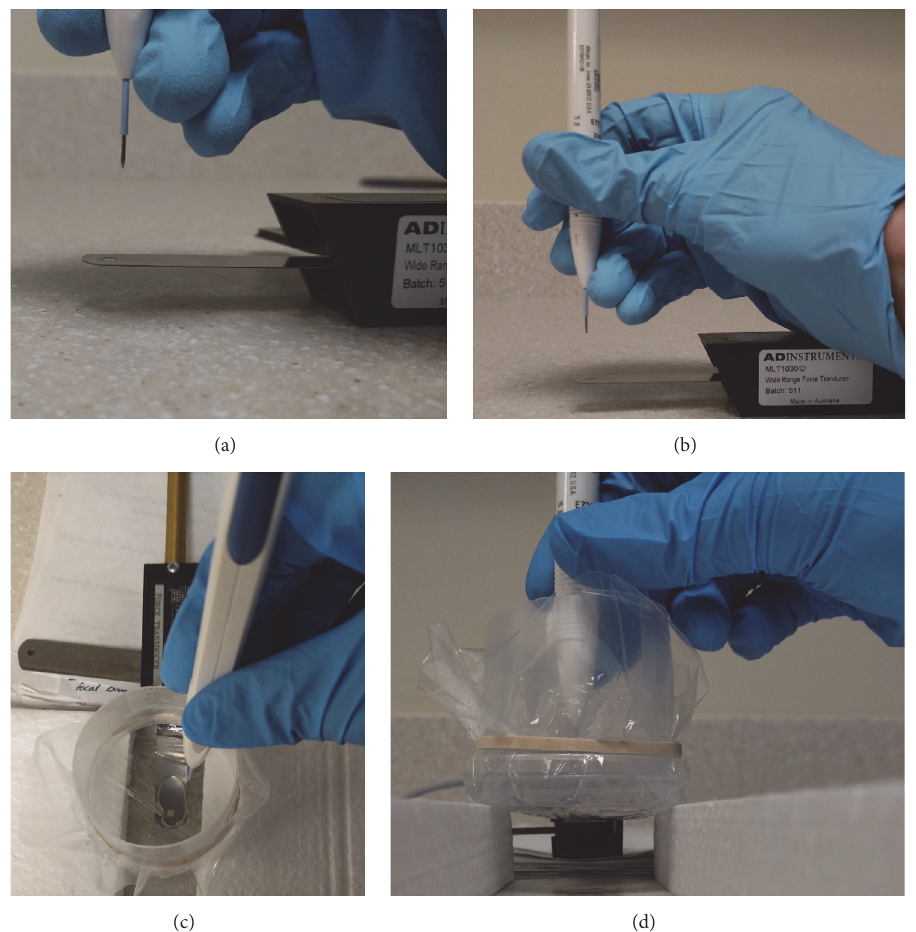
Figure 2: Experimental setup. (a) and (b) show setup for air. Ozurdex applicator held 16 mm from the force plate. Force plate readings measured in Newtons. (c) and (d) demonstrate setup for basic saline solution (BSS). Container with thin plastic bottom placed so that